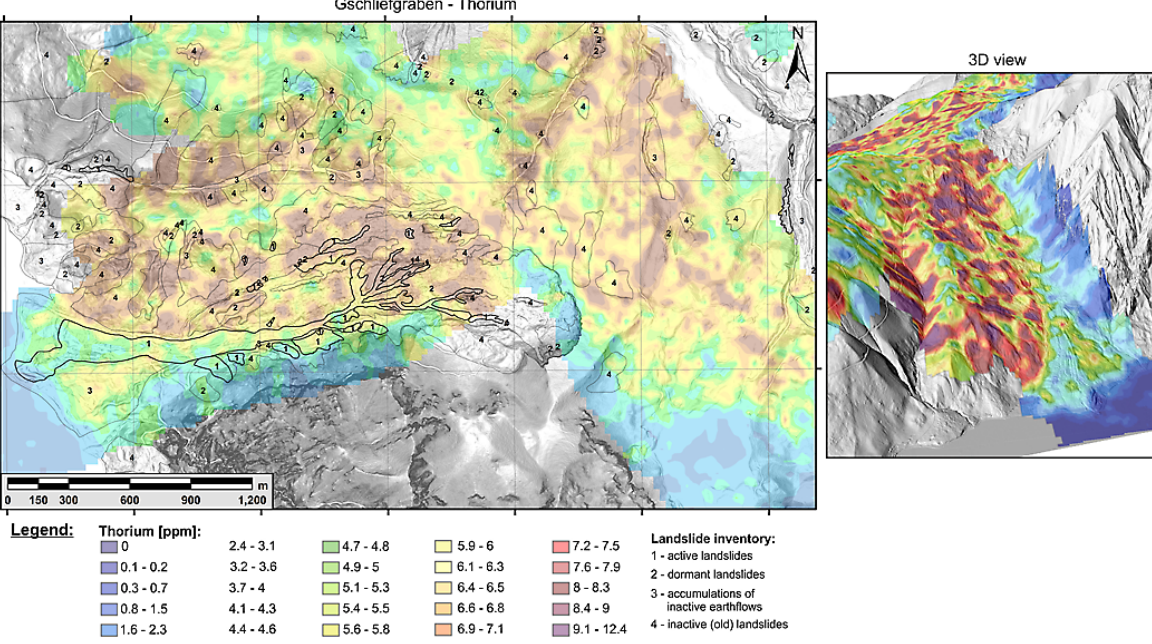
Fig. 12. Map of the thorium content at the ground surface compared to the landslide inventory map; right side: 3-D view from the